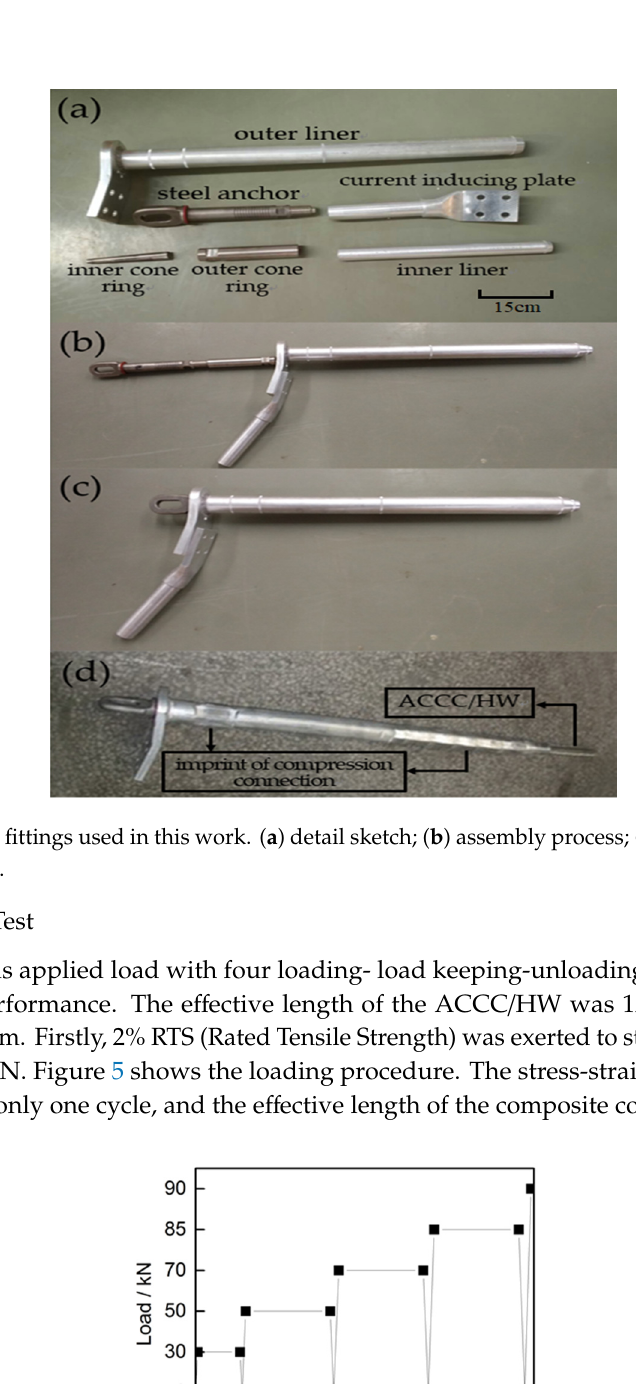
Figure 5. Stress-strain loading procedure of ACCC/HW.